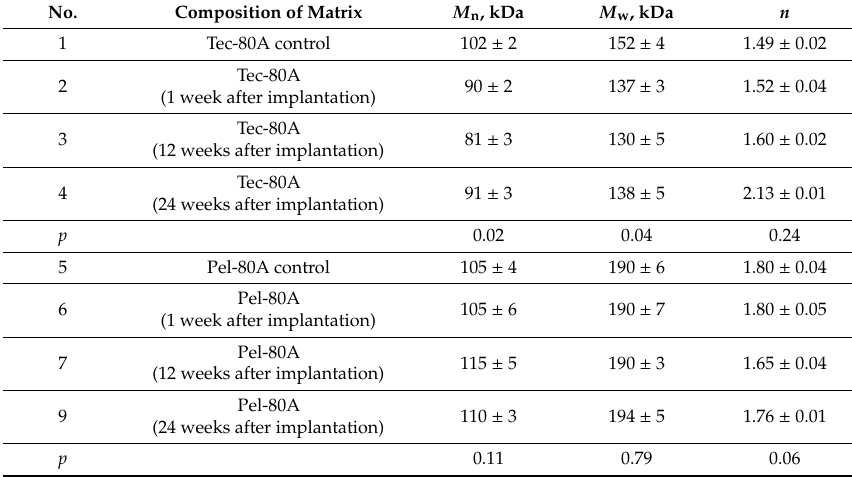
Table 1. Molecular weight characteristics ( M n , average molecular weight; M w , weight average molecular weight; and n , dispersity) of the polyurethanes extracted from vascular grafts explanted from